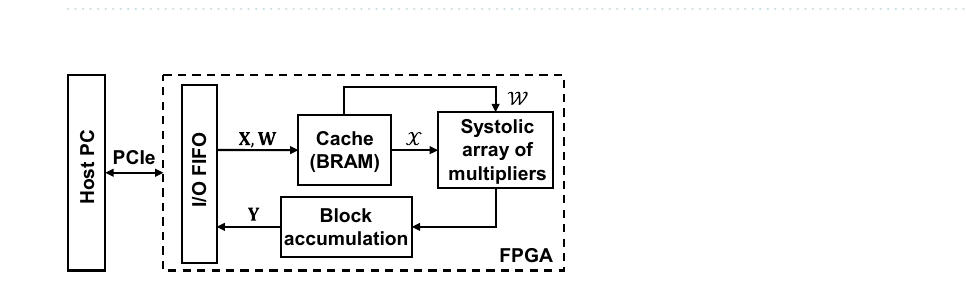
Figure 7. Normalized error vs. iteration number for the floating-point solver (dashed curve) and fixed-point iterative solver (solid curve), with adaptive exponent adjustments made every 5 steps.